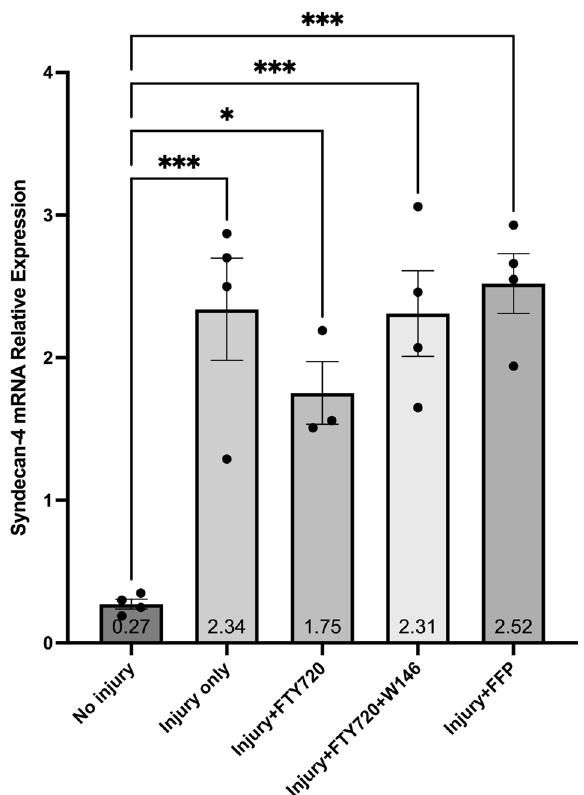
Fig. 6 Relative expression of syndecan-4 (SDC-4) mRNA. The effect of treatment with FTY720, with and without 10 µ M of the sphingosine 1-phosphate receptor 1 (S1PR 1 ) antagonist W146, or fresh frozen plasma on the relative expression of SDC-4 mRNA from injured cultured human umbilical vein endothelial cells (HUVECs). * p < 0.05, ** p < 0.01, *** p < 0.001; N 5 for each =